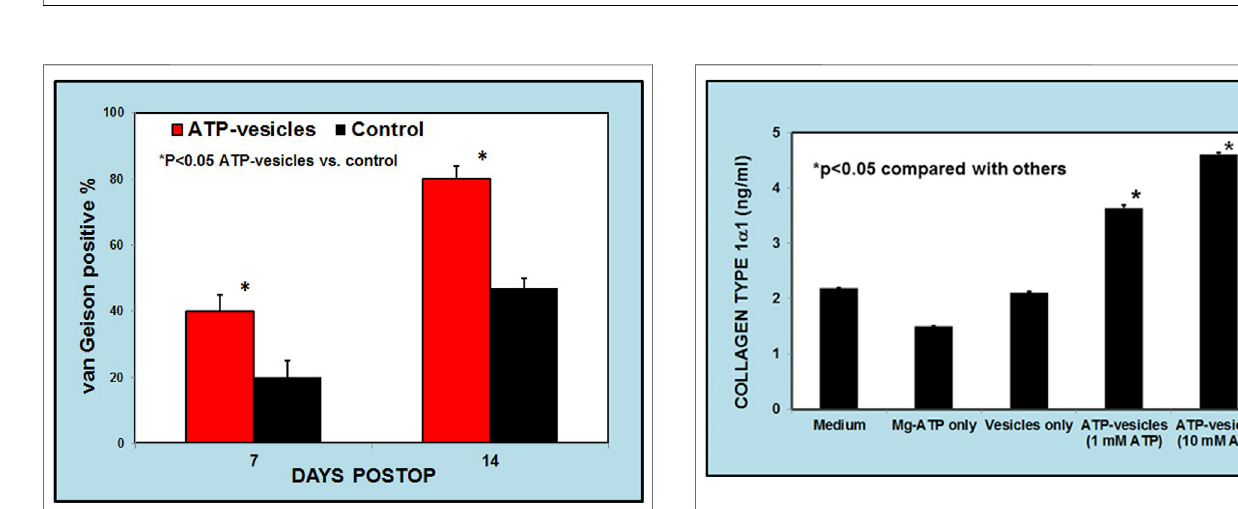
FIGURE 8 | Enzyme-linked immunosorbent assays (ELISA) of soluble collagen secreted from human macrophages in response to different treatments. Macrophages produce collagen, but addition of ATP-vesicles to the macrophages increased collagen production by two-fold while free Mg-ATP and lipid vesicles alone did not show any enhanced effect. (Mean ± SD of three independent experiments p <